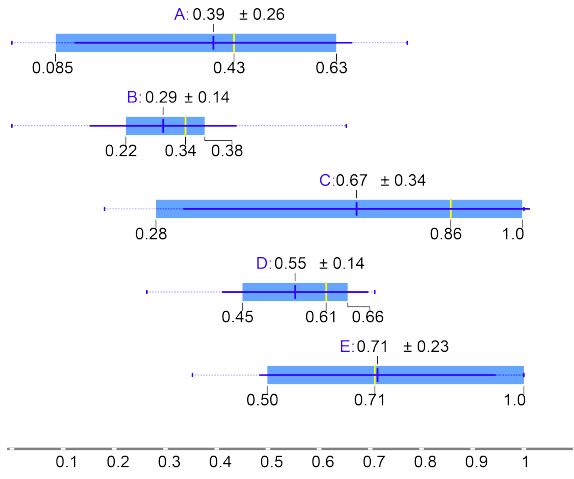
Figure 7. Boxplot presenting the level of attention averaged over all participants during the whole session divided into three (B, C, and D) separate scenarios.